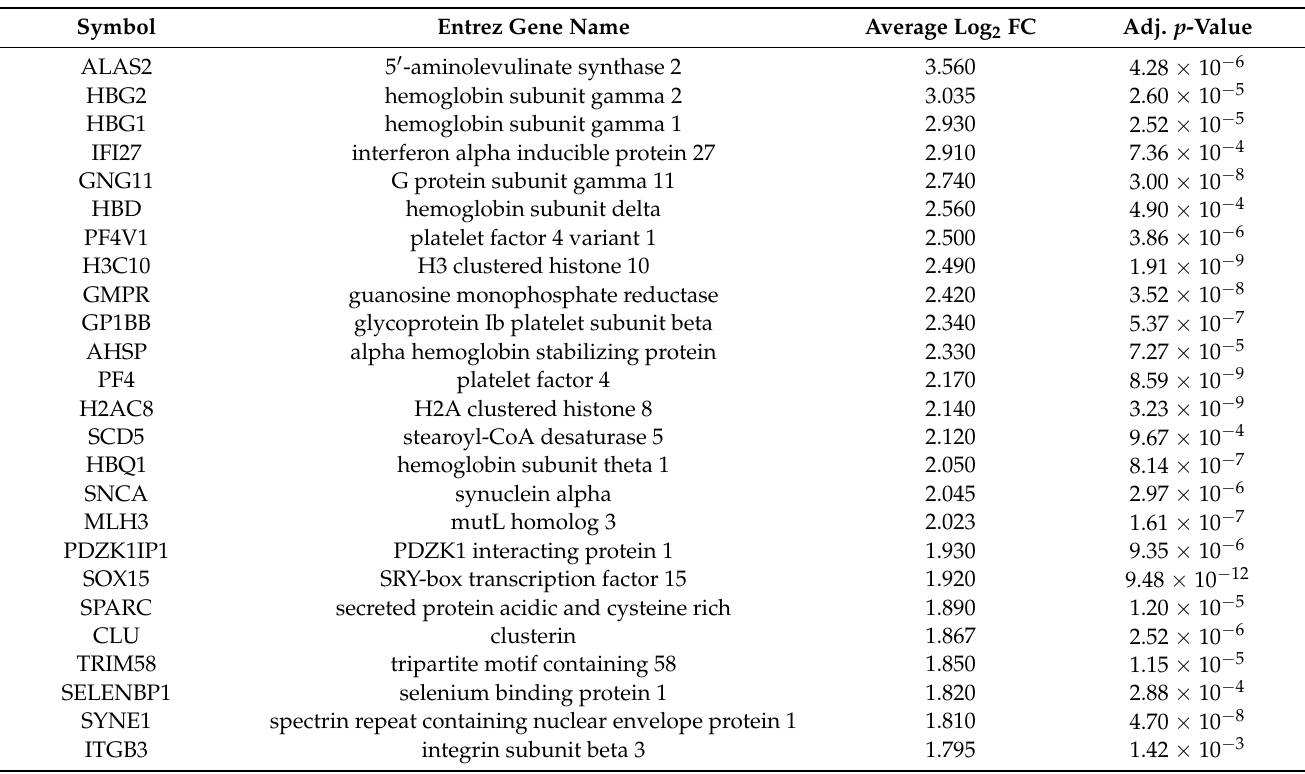
Table 1. Top 25 upregulated genes in mevalonate kinase deficiency (MKD) patients ( p -value < 0.05, log 2 FC ≥ 1.4).